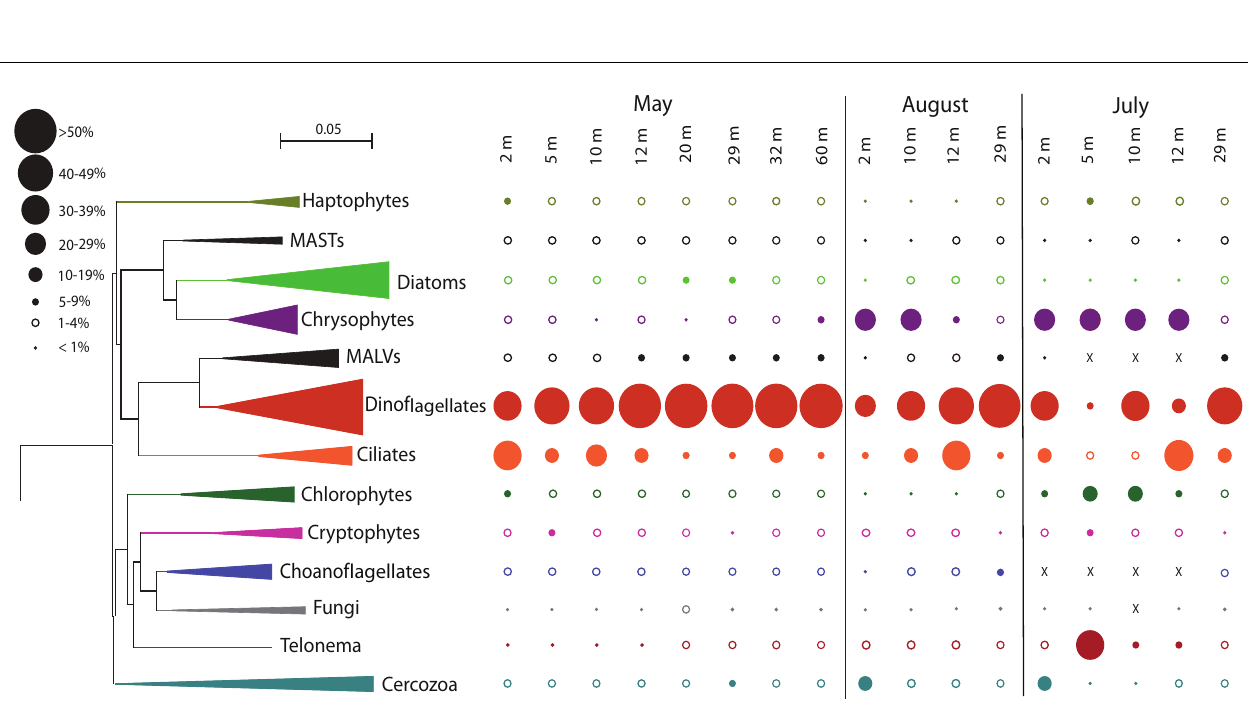
FIGURE 2 | Bray–Curtis (A) and un-weighted Unifrac (B) dendrograms based on OTUs (98% similarity) from May 2008,August 2008, and July 2009.